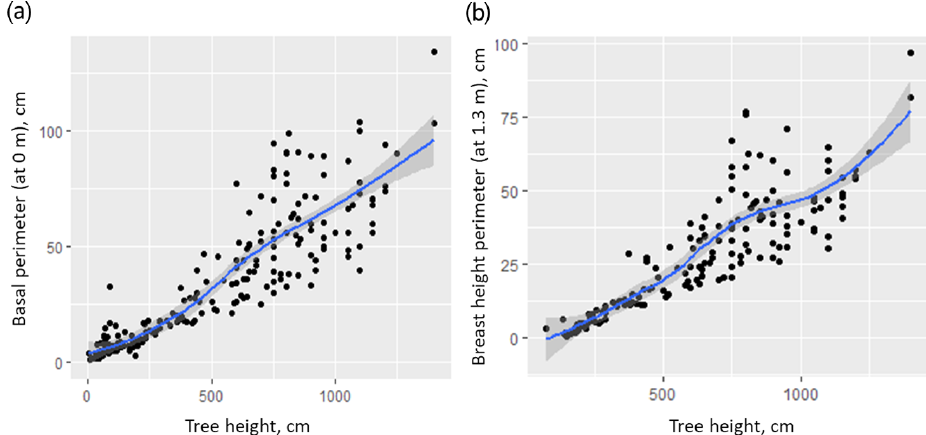
Figure A3. Relationship between tree height and perimeter of the tree stem at 0 (a) and 1.3m (b) .